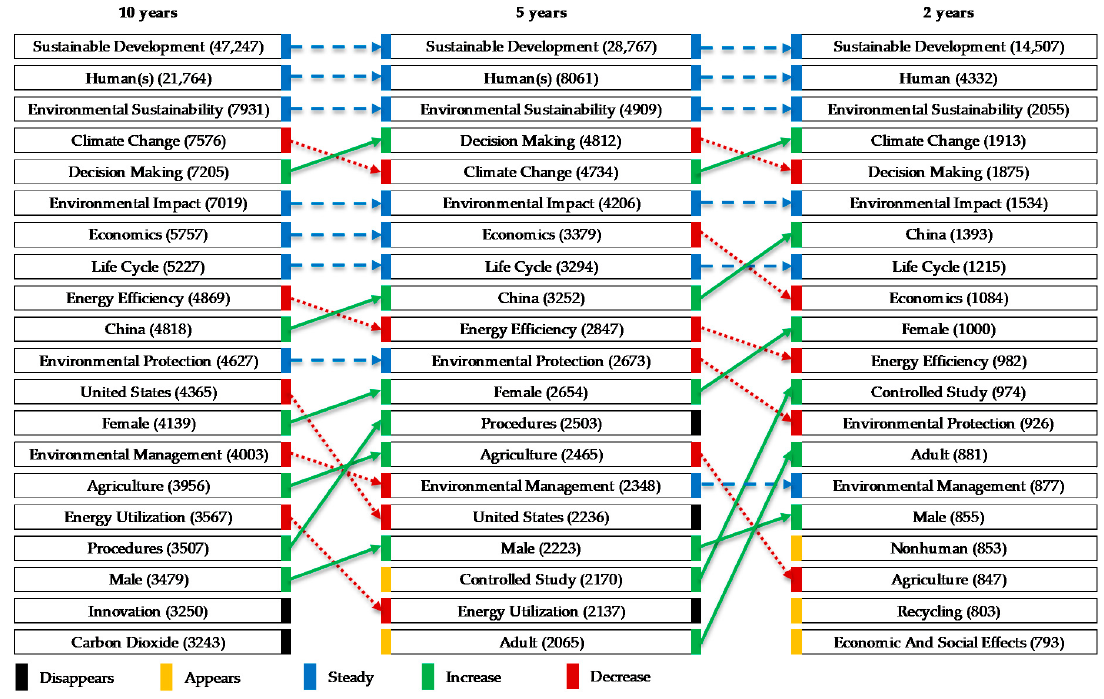
Figure 10. Evolution of the main sustainability issues in 2011–2020.